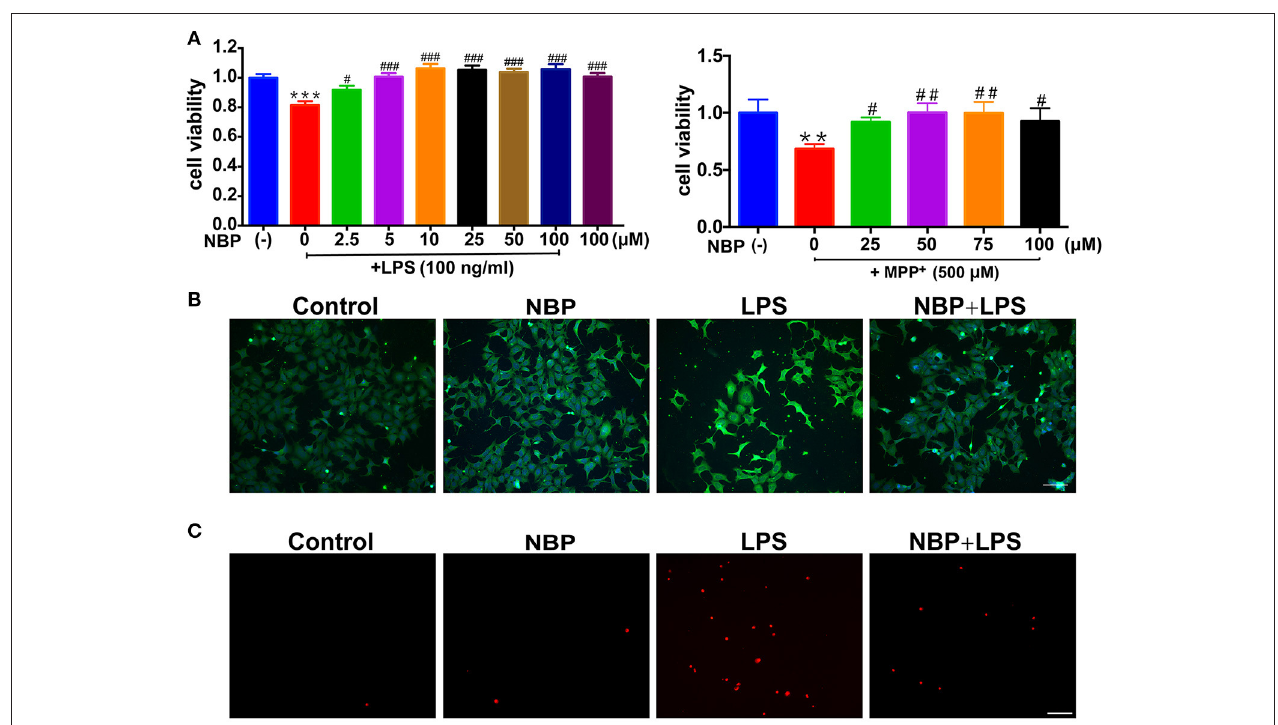
FIGURE 5 | NBP protected dopaminergic neurons from neurotoxicity induced by microglial activation. SH-SY5Y cells were incubated for 24h with conditioned medium derived from cultures of BV-2 cells. Before collecting culture media, BV-2 cells were pretreated with NBP (0 or 100 µ M) for 1h and incubated with LPS (0 or 100ng/ml) or MPP + (0 or 500 µ M) for 24h. (A) Cell viability was measured with the CCK8 assay ( n = 5). All data are presented as means ± SEM. ** p < 0.01, *** p < 0.001, compared with the Control group; # p < 0.05, ## p < 0.01, ### p < 0.001, compared with the LPS group or the MPP + group. (B) The apoptosis of SH-SY5Y was evaluated by immunofluorescence detection of cleaved caspase-3 (green) and cell nuclei was stained with DAPI (blue) (scale bar: 50 µ m). (C) The cell death of SH-SY5Y was evaluated by immunofluorescence detection of PI (red) (scale bar: 50 µ m).